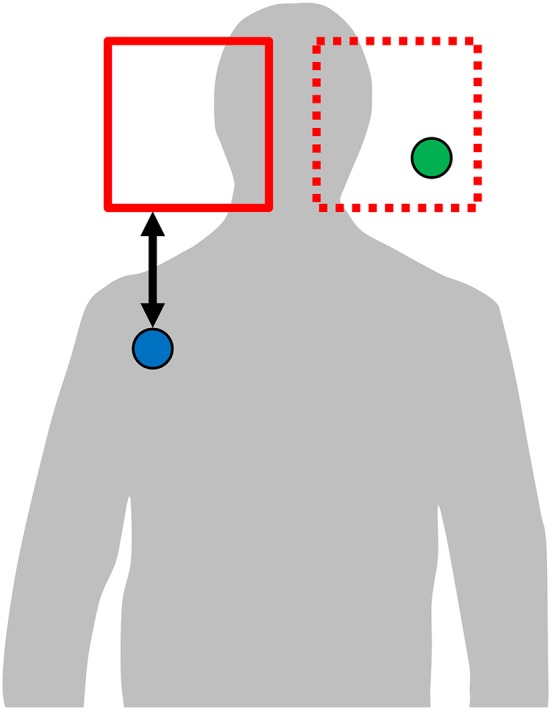
Respondents place a rectangle (red) on the part of the silhouette they judge most iconic for a concept. The rectangle's area is mirrored symmetrically (dotted red). Hand coordinates falling within either original or mirrored rectangle (green circle) receive the distance 0. Hand coordinates outside the rectangles (blue circle) receive the distance to the nearest rectangle border (black arrow).